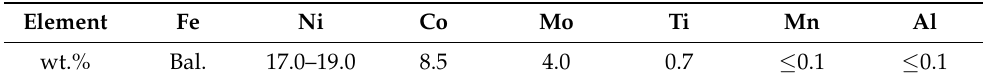
Table 1. Chemical compositions of 18Ni300 MS powder.